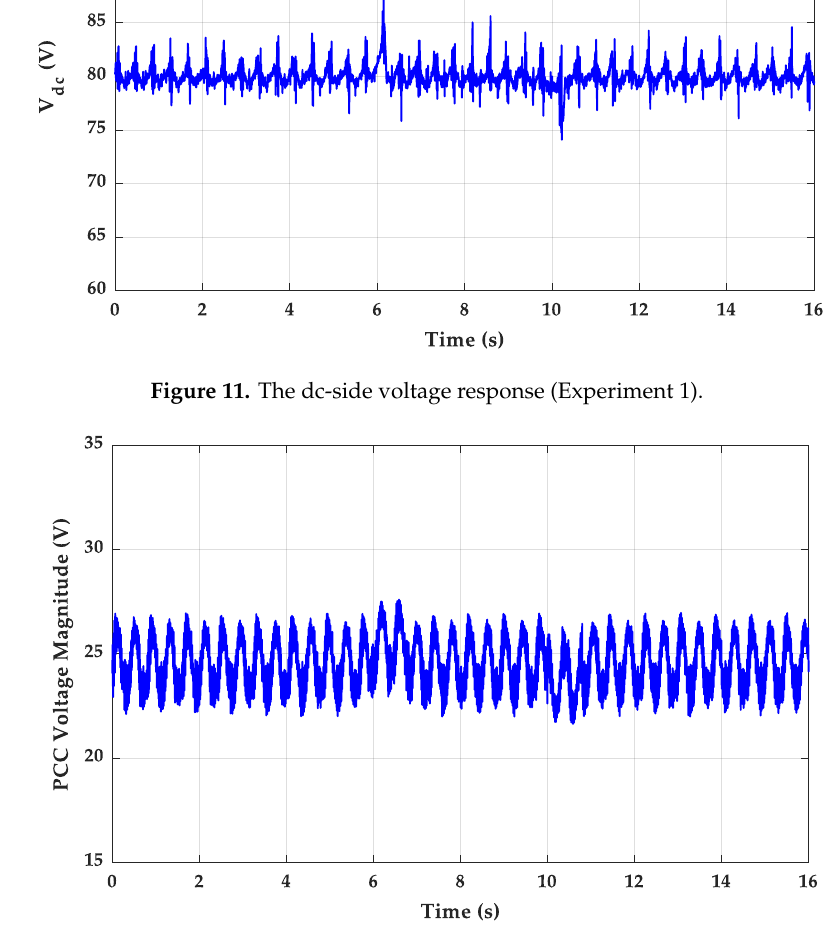
Energies 2019 , 12 , x FOR PEER REVIEW